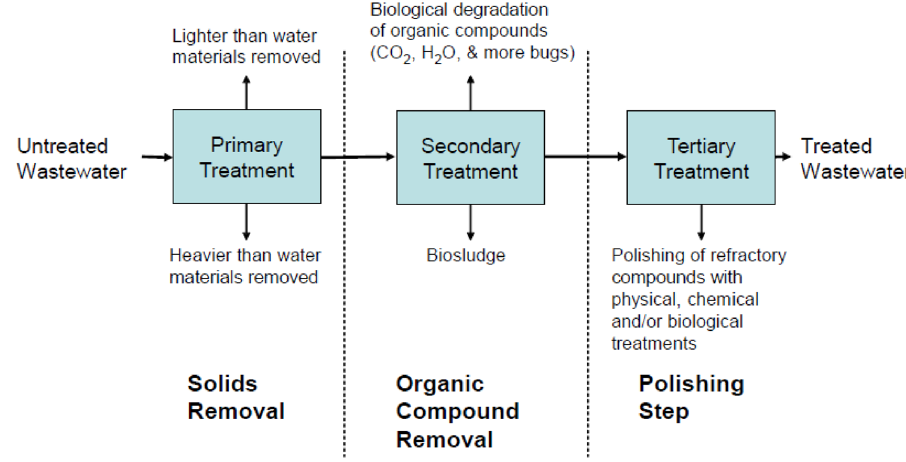
Fig. 4 Typical water treatment PFD (Kharaka et al.